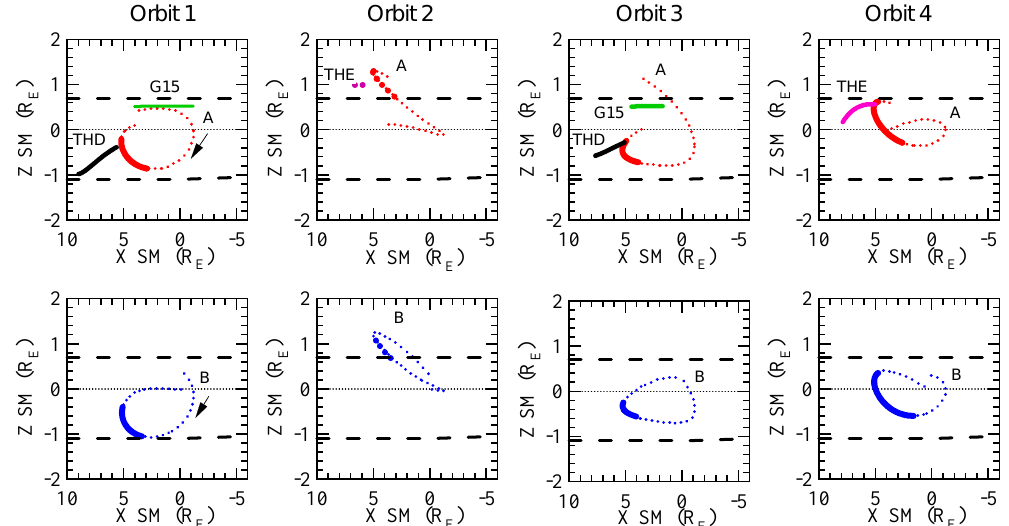
Figure 8. Four successive Van Allen Probes A and B orbits in the SM X – Z plane from 1 00:00UT on 1 May 2014 to 12:00UT on 2 May 2014. Colored lines show the locations of the spacecraft where Pc4 pulsations occurred on orbits 1, 2, 3 and 4. The pulsations were limited to − 1.1 R E < Z SM <0.7 R E (the region bounded by two dashed black lines). No magnetic field pulsations were observed during the thick dotted line segment in the Van Allen Probes A and B orbits 2 despite the spacecraft being at the appropriate local time and radial